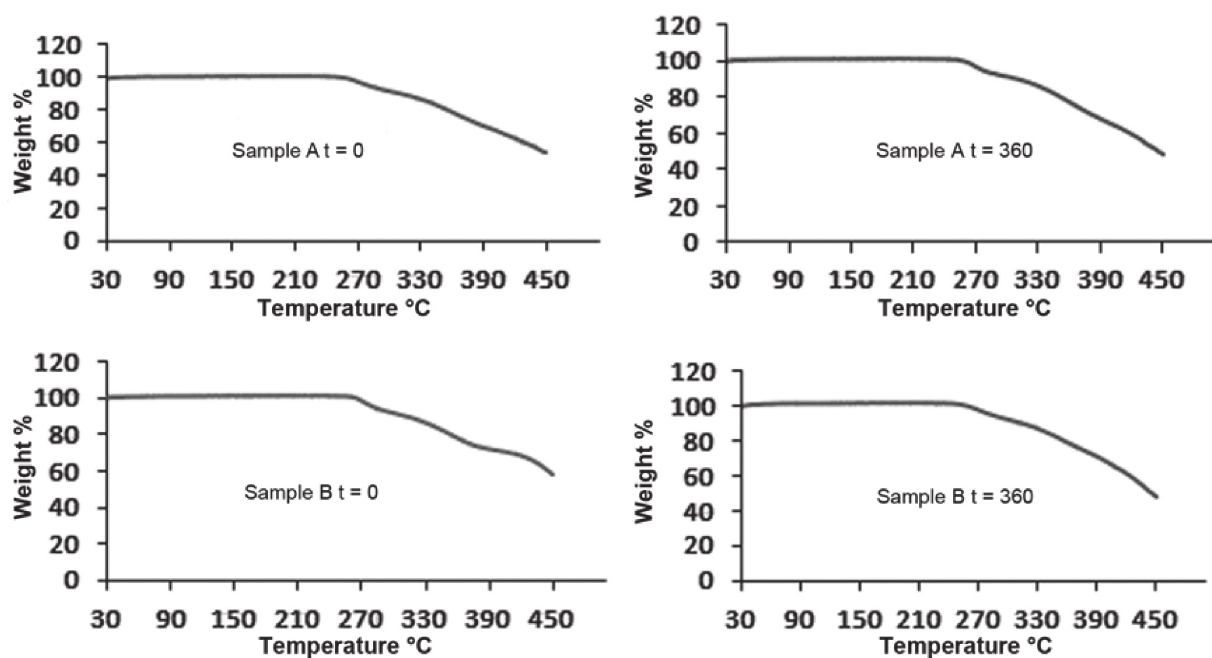
FIGURE 1 - TG curves obtained for prednisone samples A and B at zero and 360 days of study.